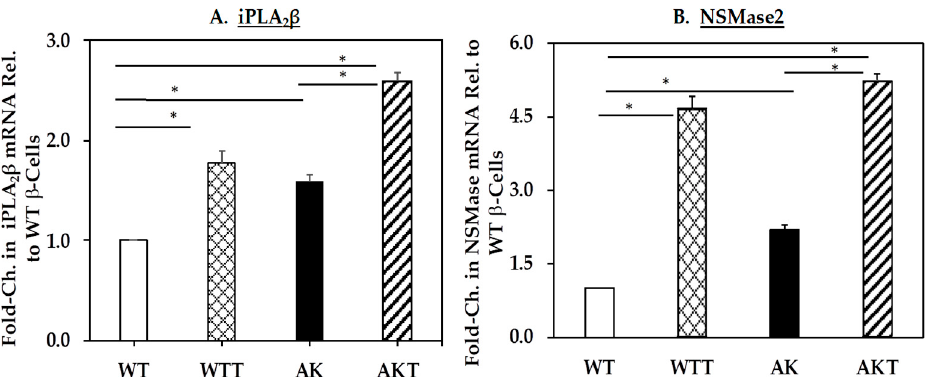
Figure 5. iPLA 2 β and NSMase expression ± thapsigargin. mRNA was determined and quantified as described in Figure 1 and expressed relative to WT controls: ( A ) iPLA 2 β mRNA; and ( B ) NSMase2 mRNA. (* Groups significantly different, p < 0.05.) Data are presented as mean ± SEM, n = 3 per group.